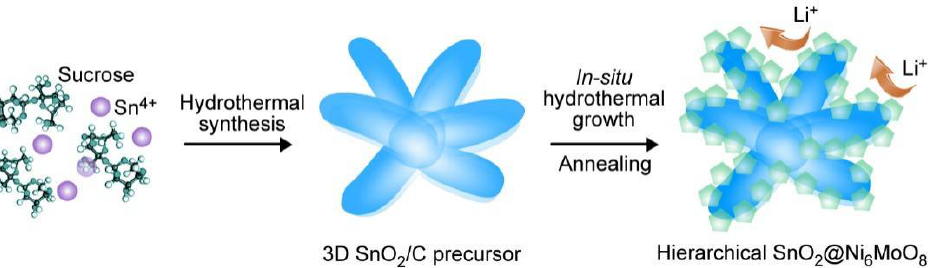
Figure 1. Preparation of a hierarchical SnO 2 @Ni 6 MnO 8 composite.